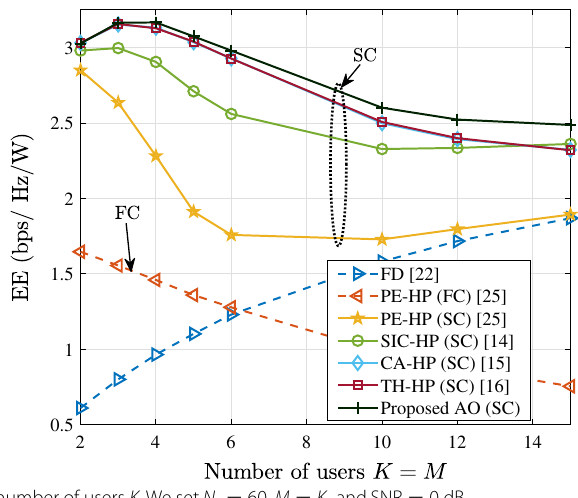
Fig. 9 EE versus number of users K . We set N t = 60 , M = K , and SNR = 0